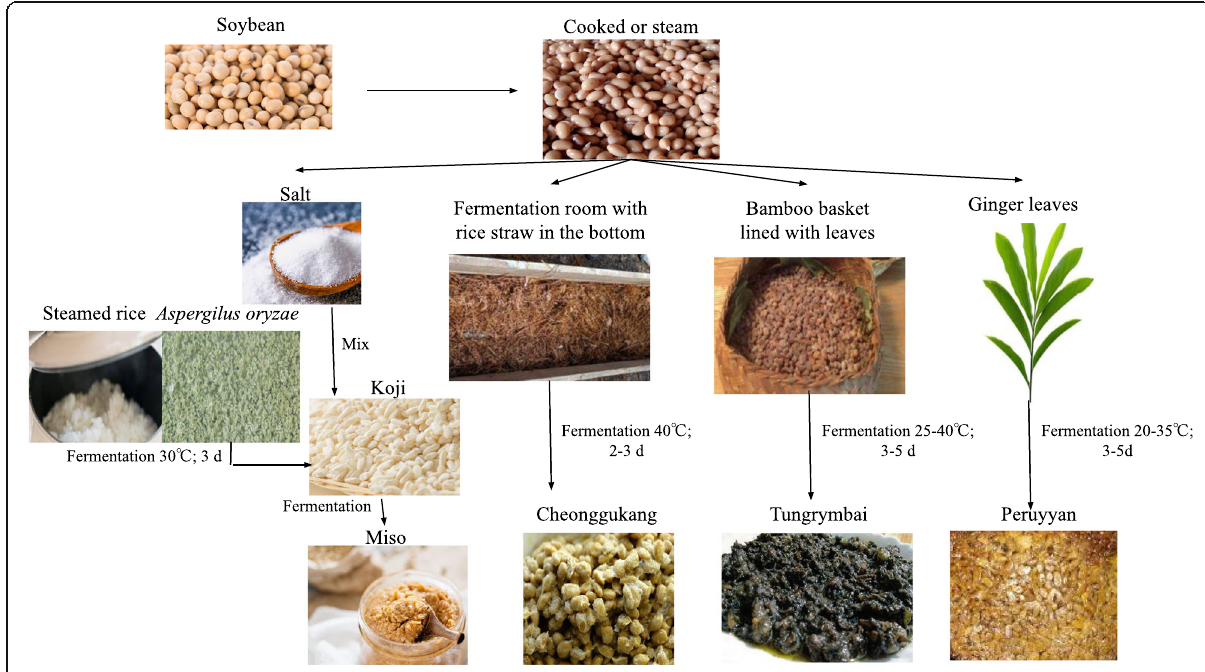
Fig. 3 Fermentation process of cooked or steamed